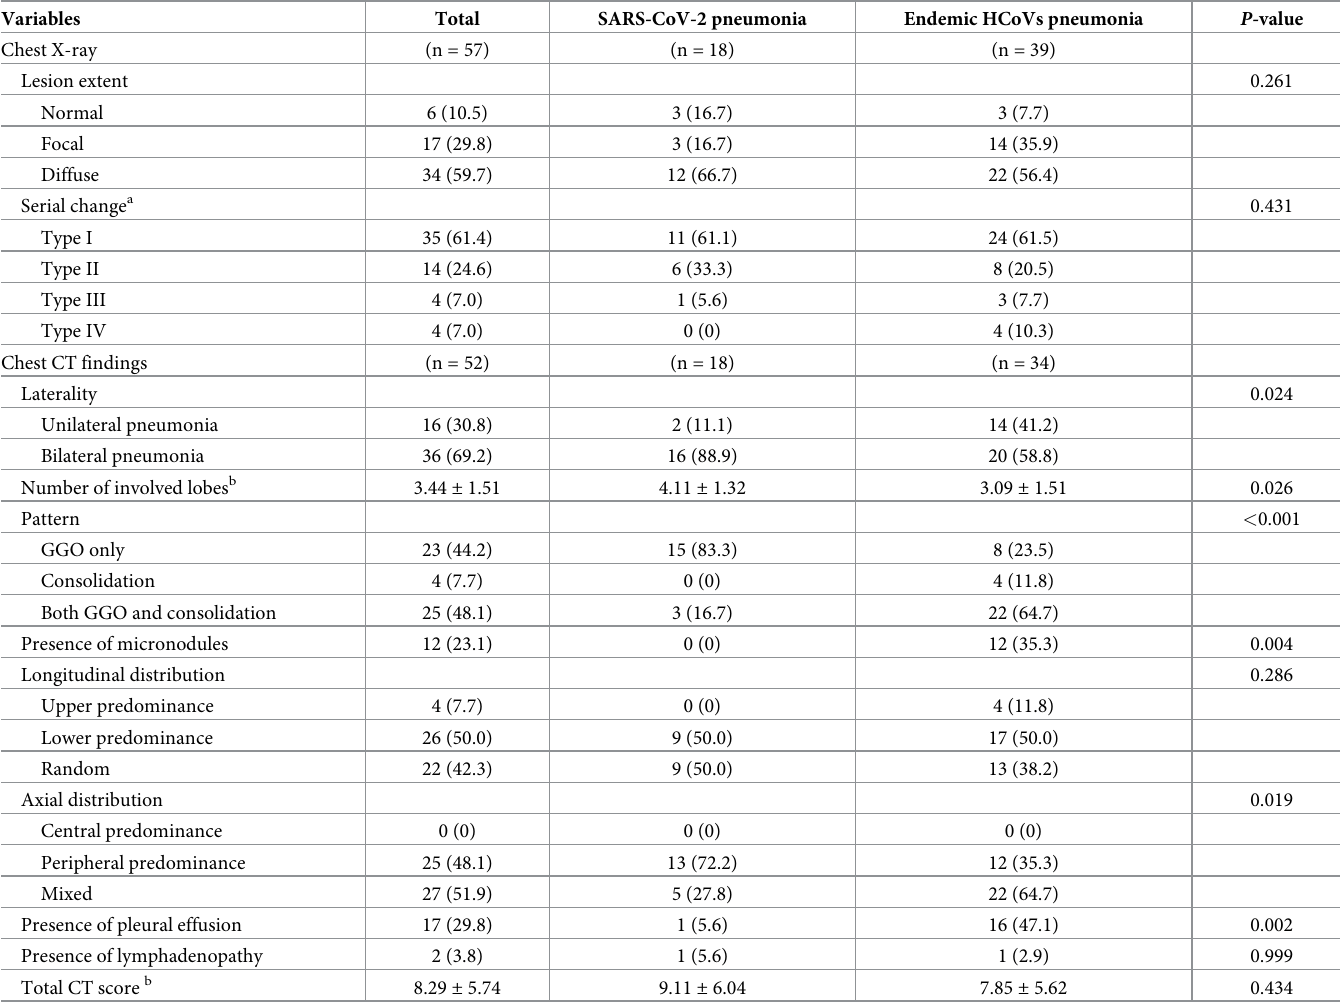
Table 3. Imaging findings of the